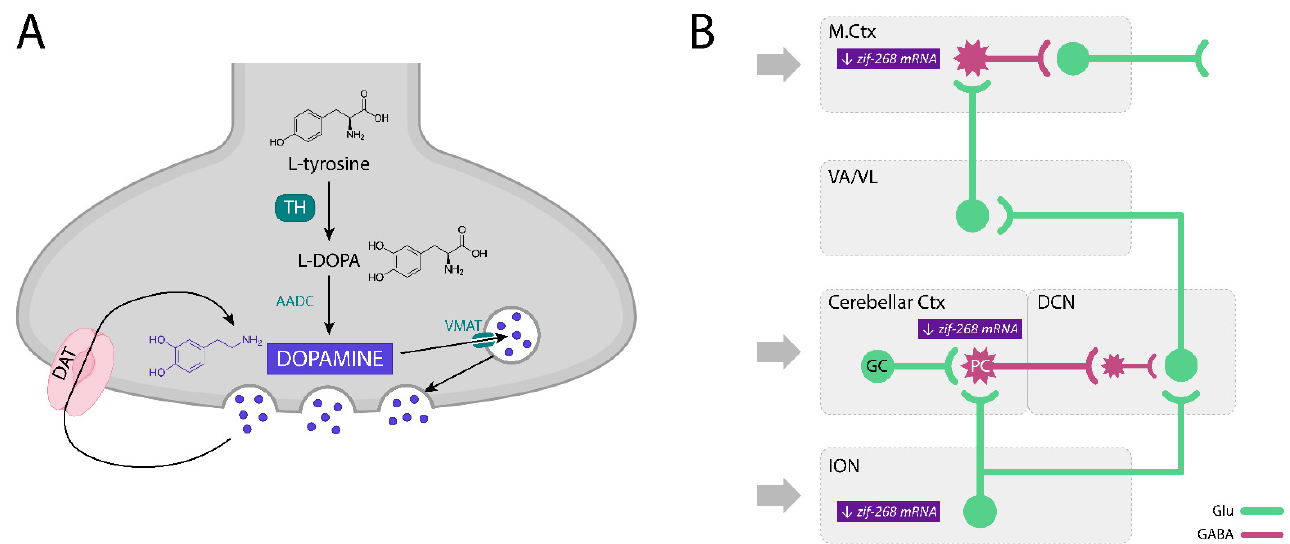
Figure 2. A scheme showing the process of dopamine synthesis within a dopaminergic neuron terminal ( A ), and brain structures potentially involved in the tremorolytic effect of pramipexole ( B ) (according to research [140]). AADC: aromatic L-amino acid decarboxylase (DOPA decarboxylase), DA: dopamine, DAT: dopamine transporter, DCN: deep cerebellar nuclei, GC: granular cell, ION: inferior olive nuclei, L-DOPA:L-3,4-dihydroxyphenylalanine (levodopa), M.Ctx: motor cortex, PC: Purkinje cell, TH: tyrosine hydroxylase, VA/VL: ventroanterior/ventrolateral thalamic nuclei, VMAT: vesicular monoamine transporter. Grey arrows indicate structures in which pramipexole inhibited zif-268 mRNA expression increased by harmaline. For additional information, see the description in the text, Section 3.2.